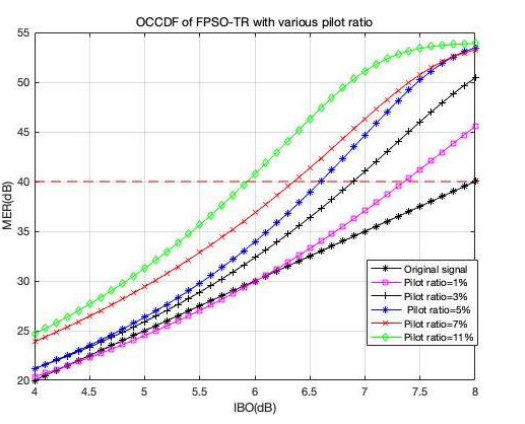
Figure 7. Relationship of IBO (dB) and pilot ratio (%) in FPSO-TR scheme.